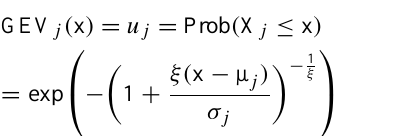
Table 1: Result of the regional multivariate test for trend detection in the ADM rainfall, ST indicates a significant trend at the 10% risk level, and δ is the trend value.